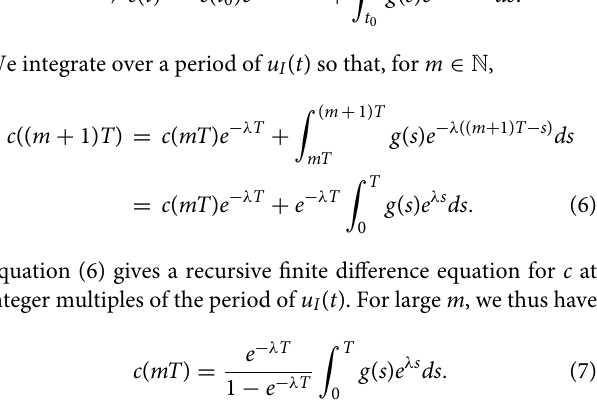
1 , (B) τ 2 , (C) = = W I 4 , I 0 10 , W E 9 . 5 = = = =